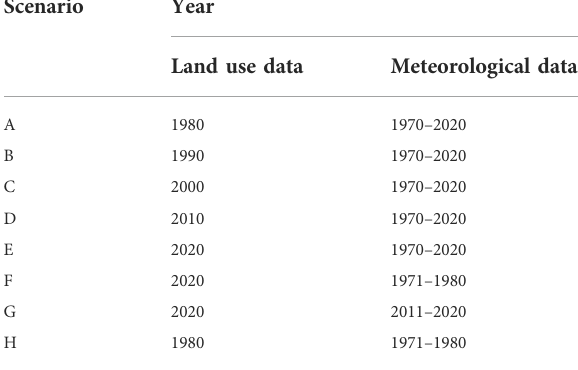
TABLE 2 Periods of land use and meteorological data considered in the scenarios.